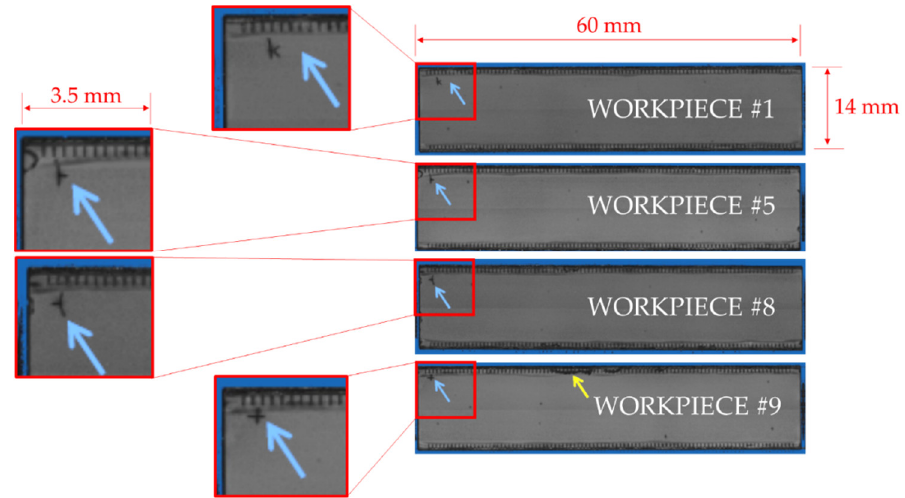
Figure 7. Latent defect detected in the workpieces at stage #3: crack in the US probe bulk (red rectangular). The detection is provided by SAM.